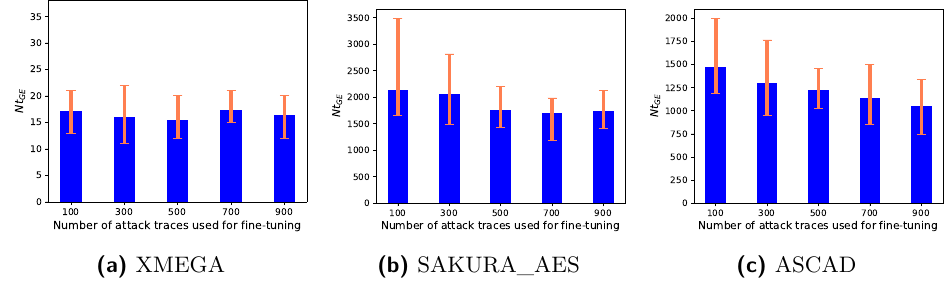
Figure 16: Attacking results of different number of fine-tuning traces (average over 20 fine-tuned